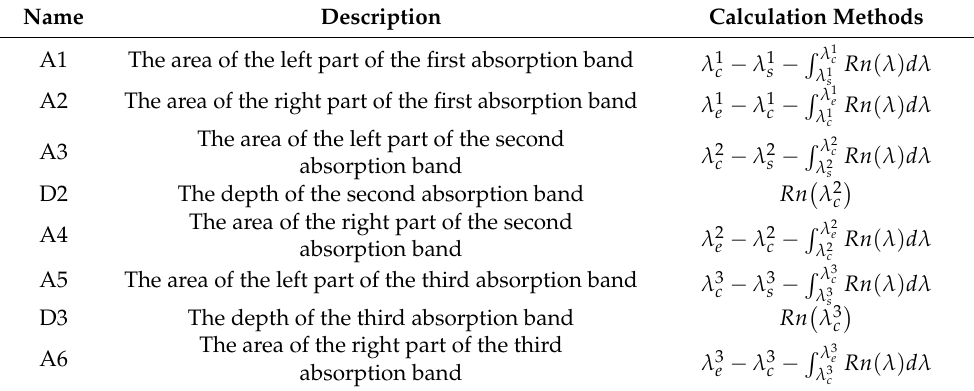
Table 2. The description and calculation method of each absorption band